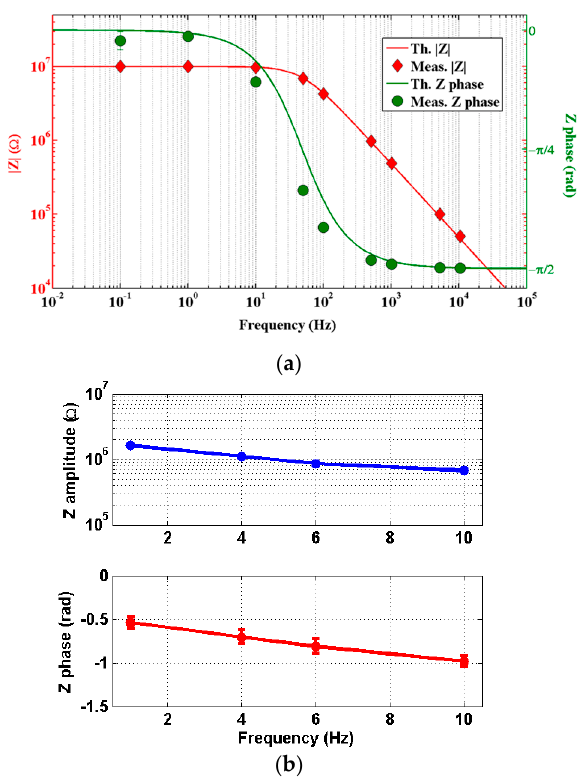
Figure 2. ( a ) Full range calibration of the portable electronic device for a parallel configuration of resistor and capacitor (experimental data) and fitting of the theoretical model; ( b ) Bare gold WE impedance amplitude and phase measured with the portable home-made electronic device in the frequency region comprised between 1 Hz and 10